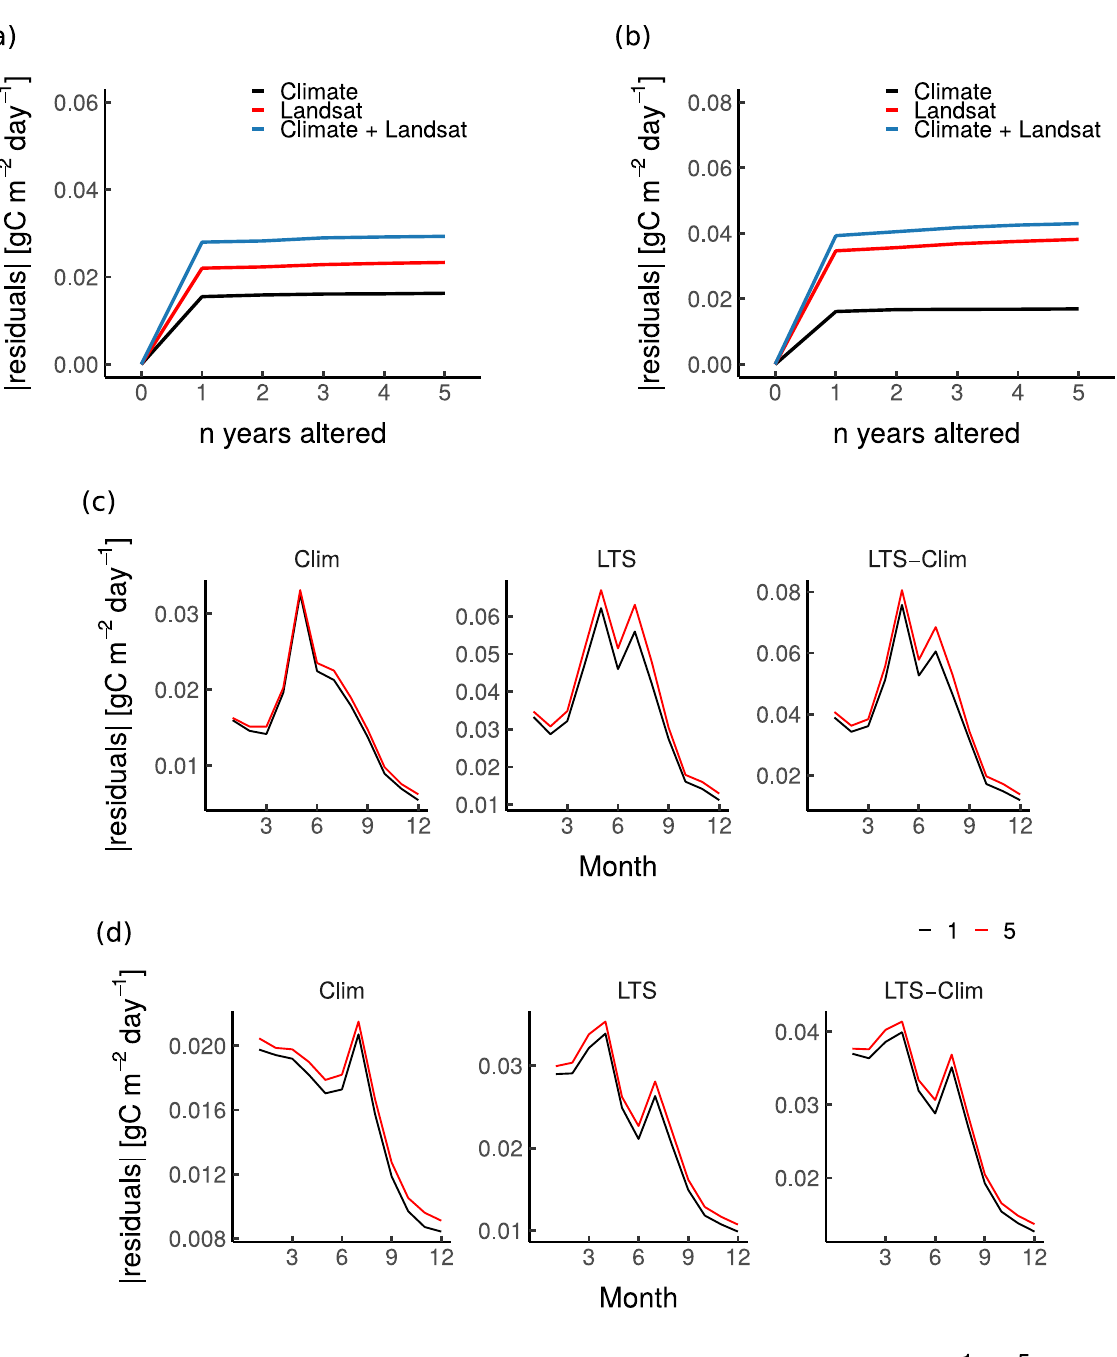
Fig 5. Effects on predicting monthly NEE by altering n year in the predictors for deciduous and evergreen forests. Average of the absolute residuals calculated between predicted monthly NEE with 0 year altered in the predictors against predicted monthly NEE with year i − n altered in the predictors for deciduous and evergreen forests (Fig 5a and b, respectively). The absolute residuals for the mean seasonal cycle were also reported (Fig 5c and d for deciduous and evergreen forests, respectively). “1 year” means that only the last year was altered, “2 years” means that the last two years were altered, and so on. Months for the sites located in the Southern hemisphere have been adjusted to match the seasonal cycle of the sites in the Northern hemisphere.